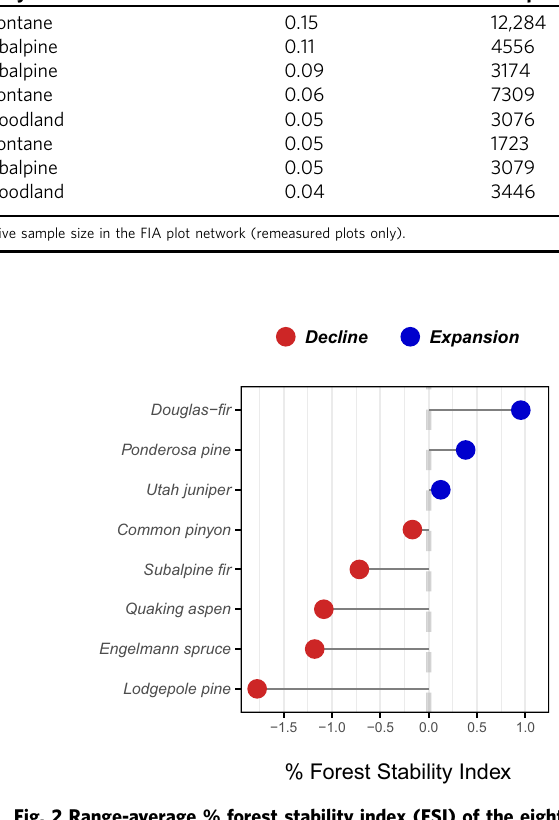
the study period (18 years). For reference, complete loss of a species over the study period would be indicated by a %FSI value of − 5.56%. Source data are provided as a Source Data fi